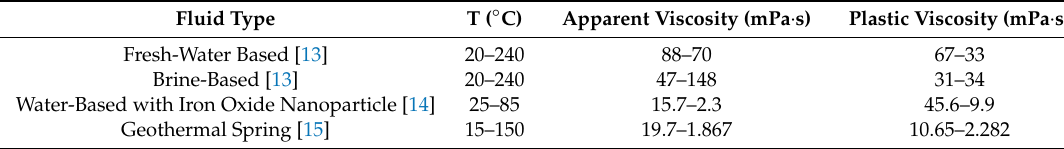
Table 1. Drilling fluid viscosities under various temperatures.